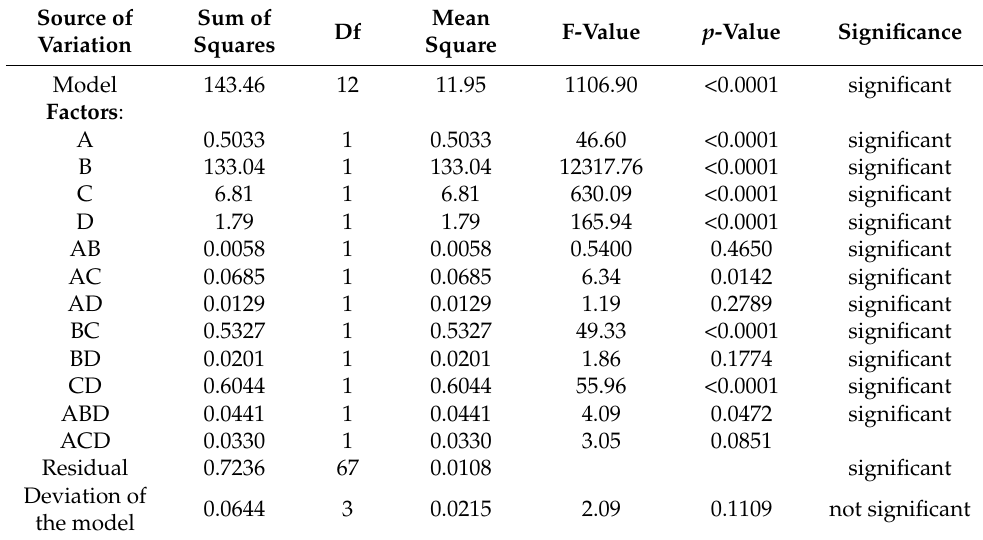
Table 5. ANOVA—Conwip.